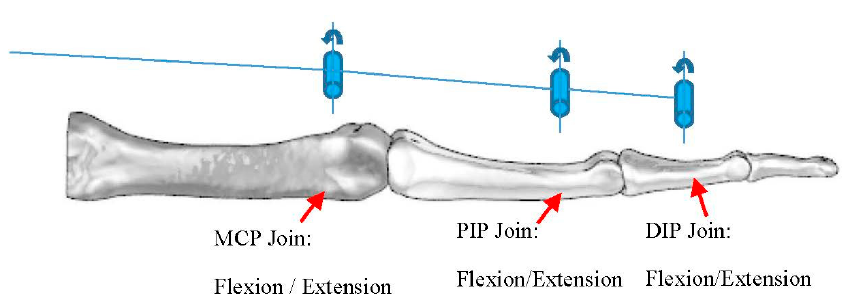
Figure 2. Three-dimensional model of the prosthetic hand assembly and its kinematics.